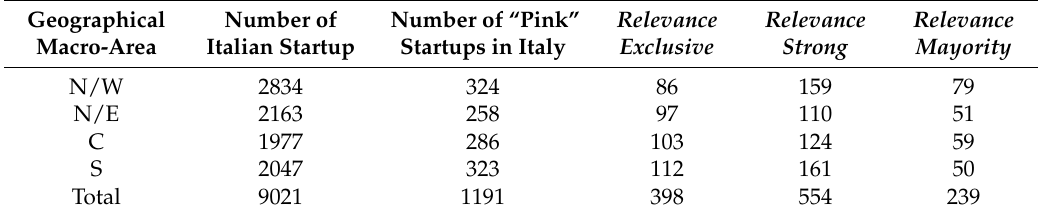
Table 2. Composition for geographical macroarea of women startups (WSU) and their type of relevance. Relevance Relevance Relevance Geographical Number of Number of “Pink” Exclusive Strong Mayority Macro-Area Italian Startup Startups in Italy N/W 2834 324 86 159 79 2163 258 97 1977 286 103 124 59 S 2047 323 112 161 50 Total 9021 1191 398 554